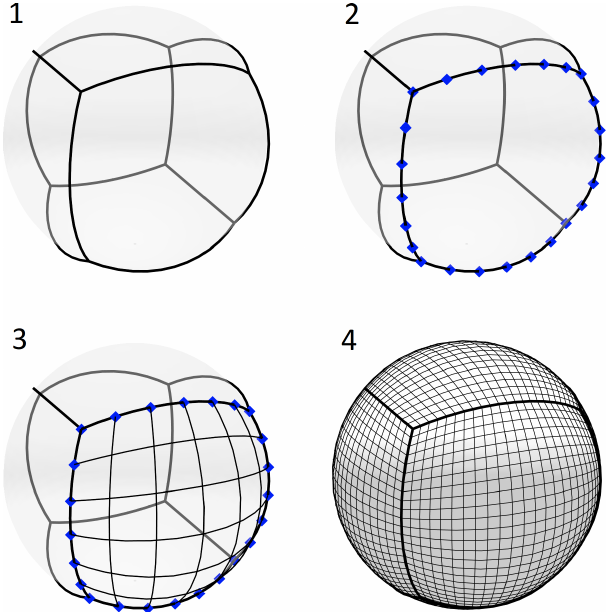
Figure 2. Graphical description of the process used to generate a gnomonic cubed-sphere grid. Subpanels are numbered based on the textual description of the steps. The grids shown are C6 and, on the final frame, C24. Demonstration is available interac- tively at http://www.geos-chem.org/cubed_sphere.html (last access: 19 July